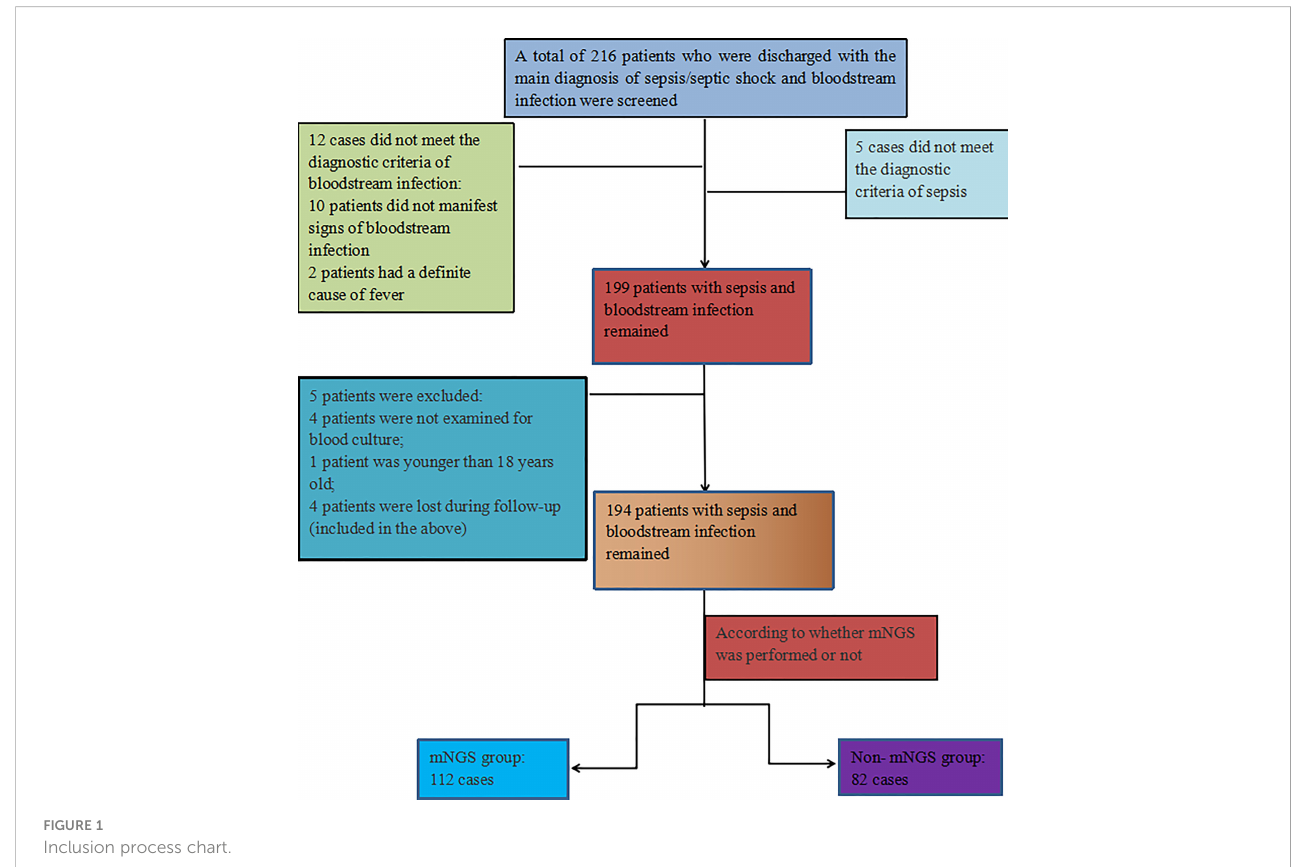
FIGURE 1 Inclusion process